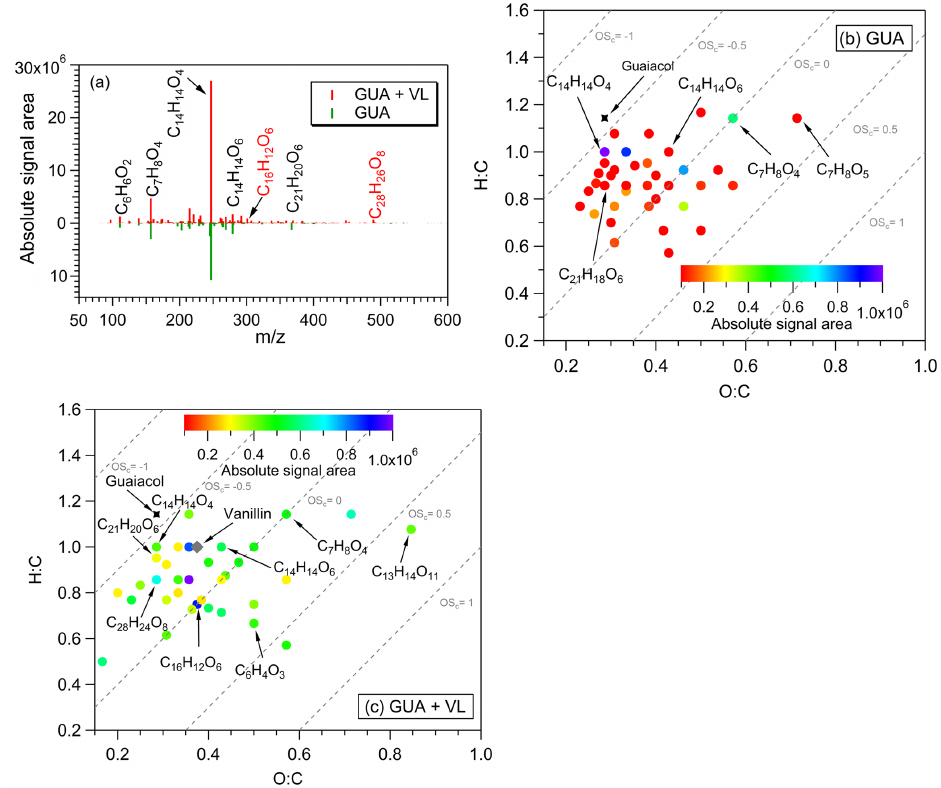
Figure 4. (a) Reconstructed mass spectra of assigned peaks from the direct GUA photodegradation (A13) and oxidation of GUA via pho- tosensitized reactions of VL (GUA + VL; A14) at pH 4 under air-saturated conditions after 6h of simulated sunlight irradiation. The y axis is the absolute signal area of the products. Examples of high-intensity peaks were labeled with the corresponding neutral formulas. The formulas in red text correspond to products observed only from GUA + VL. (b, c) Van Krevelen diagrams of the 50 most abundant products from the (b) direct photodegradation of GUA (A13) and (c) GUA + VL (A14) at pH 4 under air-saturated conditions after 6h of simulated sunlight irradiation. The color bar denotes the absolute signal area. The gray dashed lines indicate the carbon oxidation state values (e.g., OS c = − 1, 0, and